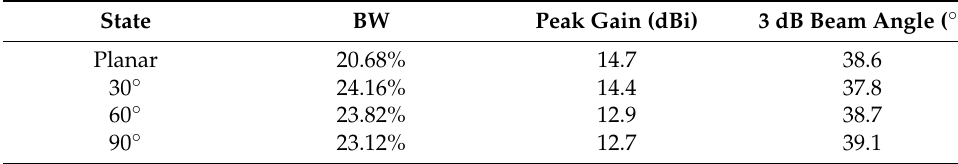
Figure 16. The simulated and measured reflection coefficient of the proposed antenna array under various bending states and on the plane. The inset illustrated the bending state.